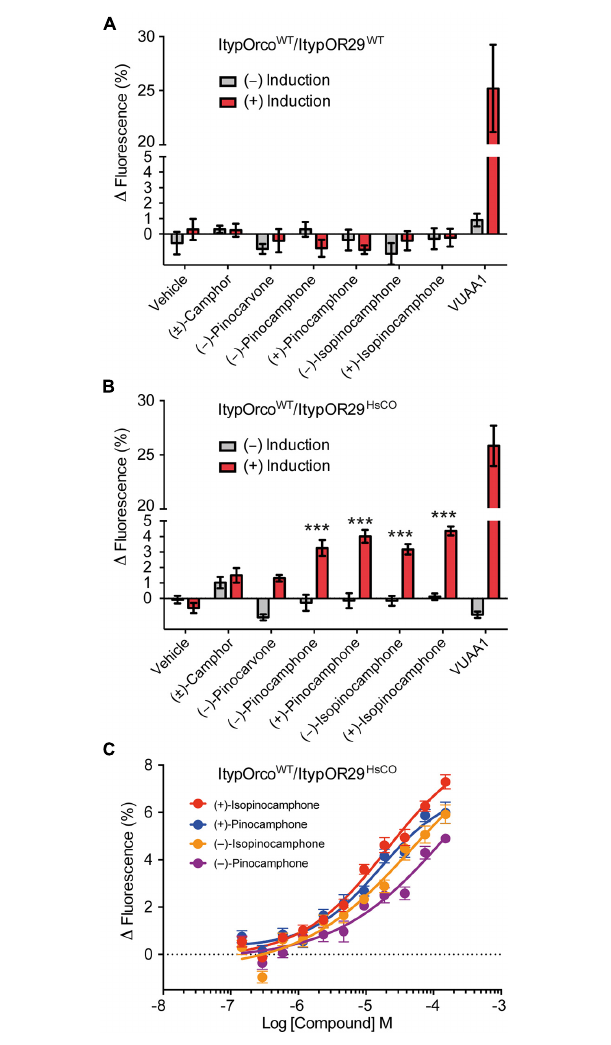
FIGURE 5 | Response of cells co-expressing wildtype I. typographus Orco (ItypOrco WT ) and wildtype or codon optimized (HsCO) ItypOR29 to select compounds. (A) ItypOR29 WT did not respond to any compound in the screening experiments (30 µ M concentration; n = 2 biological replicates; n total = 6). (B) ItypOR29 HsCO responded primarily to (+)-isopinocamphone followed by (+)-pinocamphone, ( − )-pinocamphone, and ( − )-isopinocamphone in the screening experiment ( n = 3 biological replicates, n total = 9). Asterisks (***) indicate significantly higher response in induced (+) versus non-induced ( − ) cells at p < 0.001. Responses to the four active compounds were not significantly different ( p = 0.059). (C) Dose-dependent response of ItypOR29 HsCO to the four active ligands ( n = 3 biological replicates; n total = 9). Error bars show SEM. EC 50 values were not calculated due to non-sigmoid dose-response curves. Responses of ItypOR29 WT and ItypOR29 HsCO to the full odor panel are presented in Supplementary Figure 2